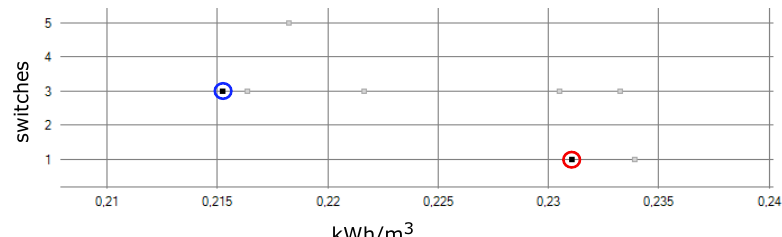
Figure 8. Decision support system for pump operation: The software presents the best solutions concerning the specific energy (blue circle) and number of switches (red circle). Inferior solutions are filtered